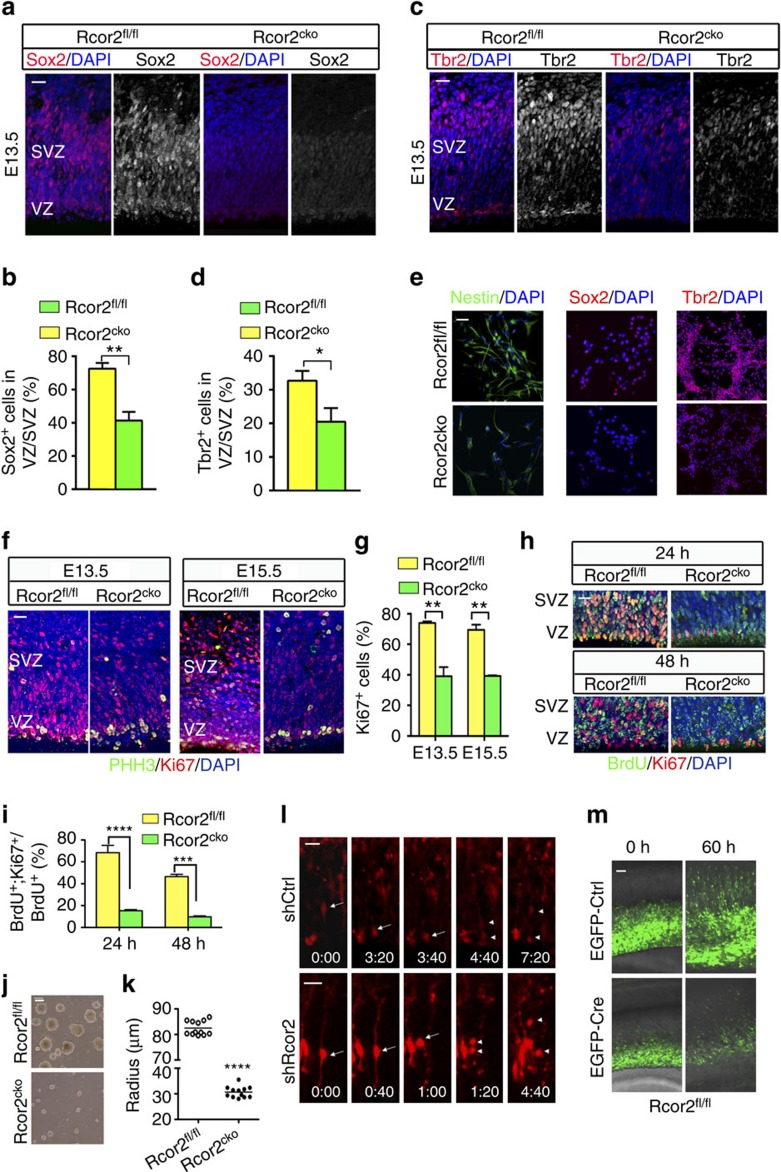
Rcor2 regulates cortical NSC/NPC population and proliferation during development.(a) Immunostaining images of Sox2 at E13.5. Sox2 is dramatically reduced on Rcor2 depletion. VZ, ventricular zone; SVZ, subventricular zone. Scale bar, 20 μm. (b) Quantification of Sox2+ cell ratios in VZ/SVZ regions shown in a. Data are shown as mean±s.e.m., t-test, ** P<0.01, n=3 individual experiments. (c) Confocal images of Tbr2 expression at E13.5. Tbr2 is dramatically reduced on Rcor2 depletion. Scale bar, 20 μm. (d) Quantification of Tbr2+ cell ratios in VZ/SVZ regions shown in c, respectively. Data are shown as mean±s.e.m., t-test, *P<0.05, n=3 individual experiments. (e) Immunostaining images of Nestin, Sox2 and Tbr2 in cultured Rcor2fl/fl and Rcor2cko NPCs, all of which exhibit significantly reduced expression in the Rcor2cko NPCs. Scale bar, 20 μm. (f) Confocal images of immunofluorescence for Ki67 and PHH3 in Rcor2fl/fl and Rcor2cko cortex at E13.5 and E15.5. Ki67 signals (red), but not PHH3 signals (green), are dramatically reduced in Rcor2cko developing brains. Scale bar, 20 μm. (g) Quantification of Ki67+ cells in the VZ/SVZ regions of the developing neocortex as shown in f. Data are shown as mean±s.e.m., t-test, **P<0.01, n=3 separate stainings from three independent brains. (h) Confocal images of BrdU (green) and Ki67 (red) staining in Rcor2fl/fl and Rcor2cko cortex 24 and 48 h after BrdU incorporation. Scale bar, 100 μm. (i) Quantification of the cell cycle exit by percentage of BrdU+ and Ki67+ NPCs divided by BrdU+ cells shown in h. Data are shown as mean±s.e.m., t-test, ***P<0.001 and ****P<0.0001, n=3 individual experiments. (j,k) Representative images (j) and quantification of (k) of Rcor2fl/fl and Rcor2cko neurosphere sizes. The neurospheres'radius of Rcor2cko are much smaller than those of Rcor2fl/fl, t-test, ****P<0.0001, n=12. Scale bar, 50 μm. (l) Representative time-lapse imaging of the RGC dividing process in the sections of the cerebral cortex electroporated with RFP-shControl (upper panels) and RFP-shRcor2 (lower panels). The radial glial dividing pattern is abnormal on Rcor2 knockdown, resulting in cell death. Arrows, mother RGCs. Arrowheads, two daughter cells. Scale bar, 50 μm. (m) Representative time-lapse images of Rcor2fl/fl cortex sections electroporated with EGFP-Control (upper panels) and EGFP-Cre (lower panels). Loss of cells is observed with Rcor2 knockout by Cre recombinase electroporation. Scale bar, 50 μm.